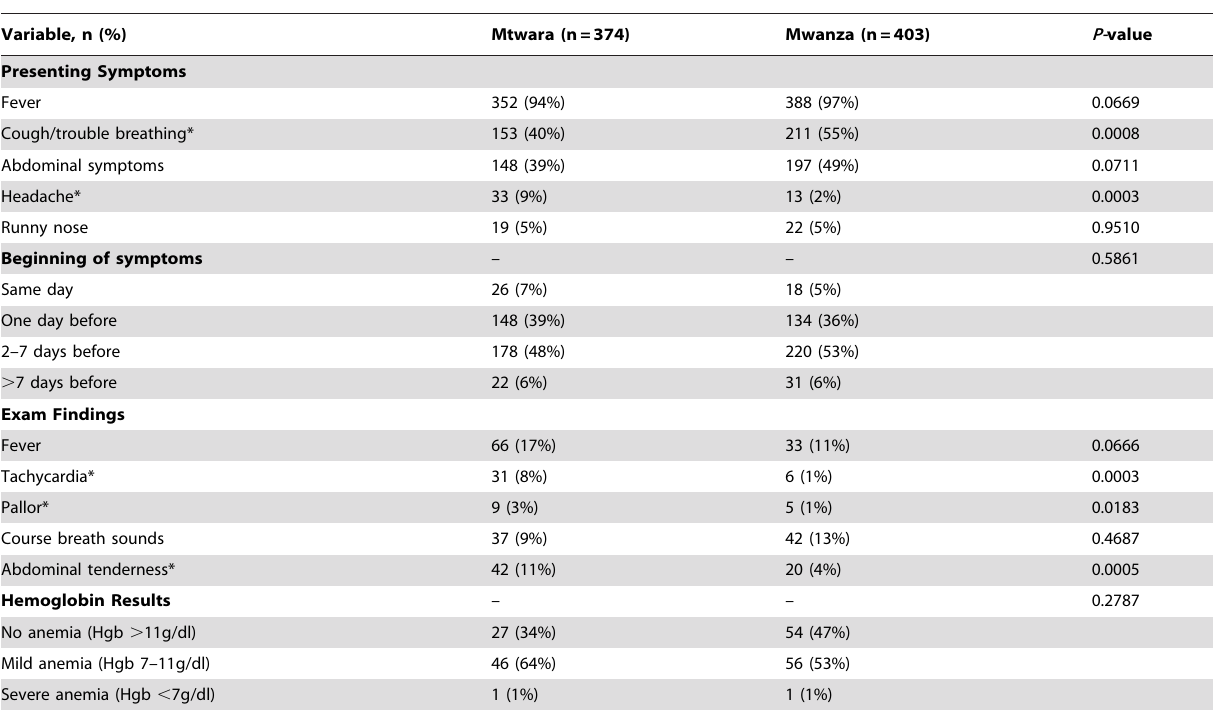
Table 3. Client Illness History and Exam Findings Stratified by Region.